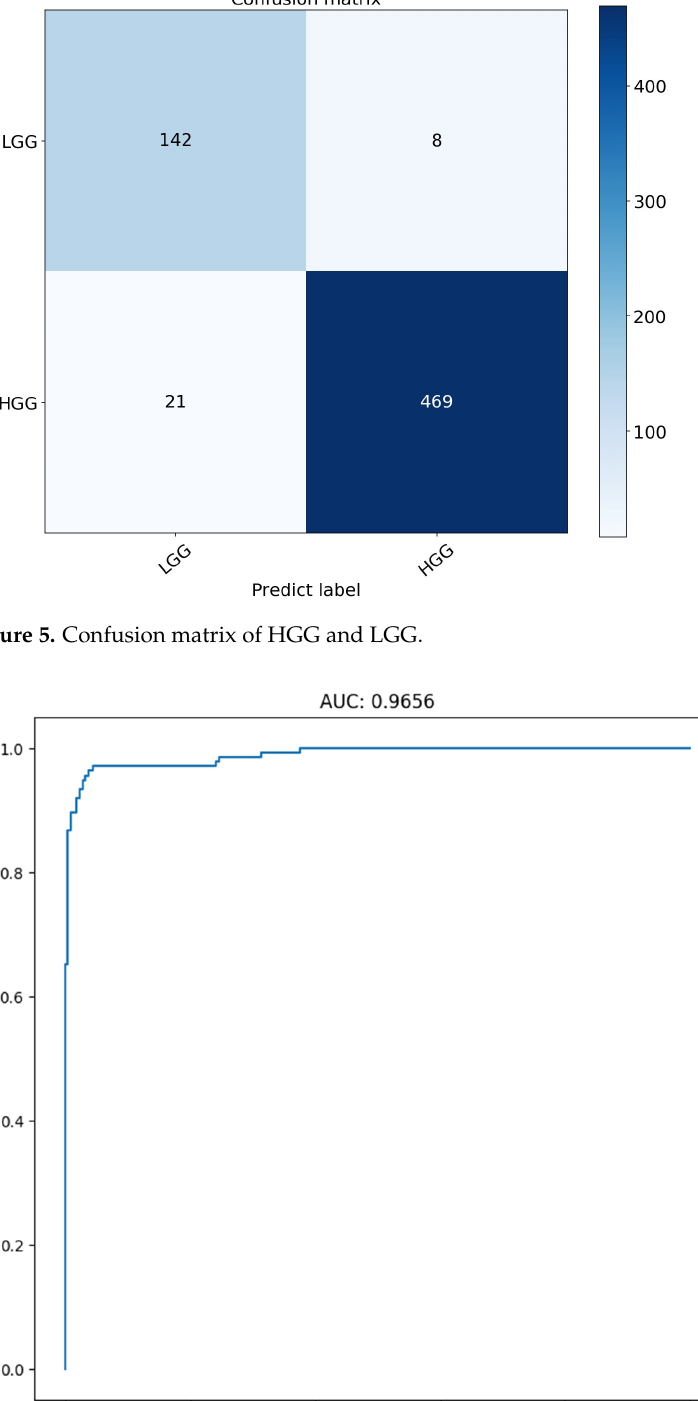
Figure 6. ROC curve of the brain tumor classification model.